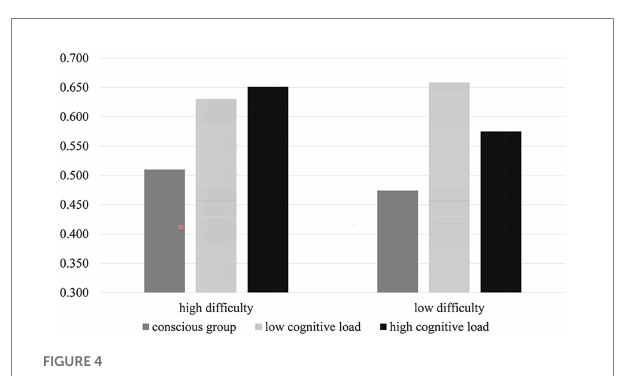
FIGURE 4 The accuracy rate of Experiment